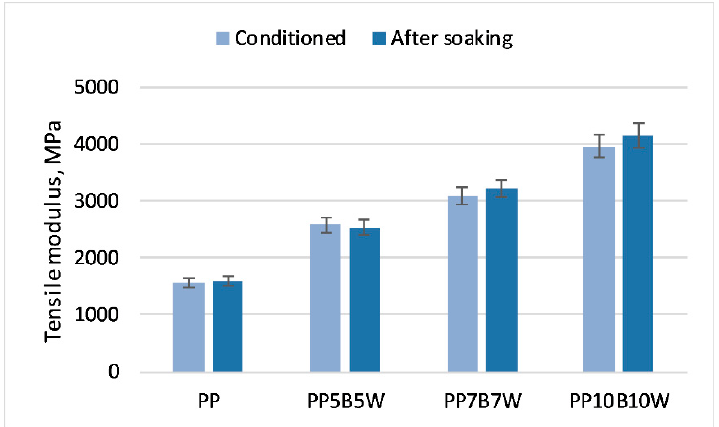
Figure 9. Tensile modulus of the tested materials in the conditioned state and after soaking in water for 30 days.